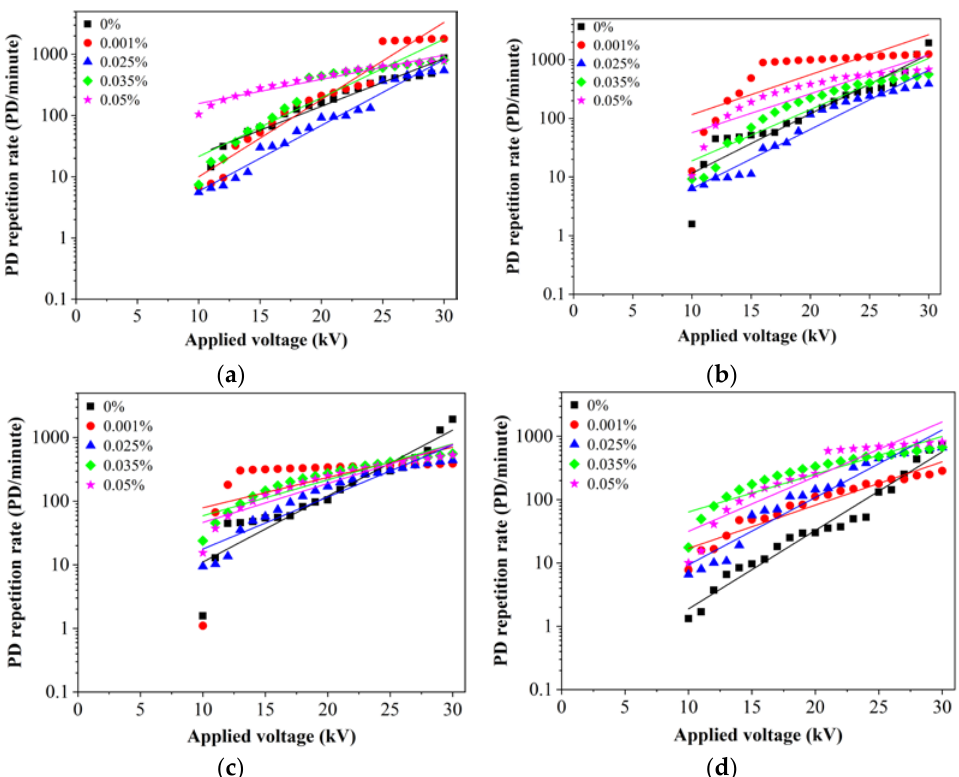
Figure 8. PD repetition rate versus applied voltage for ( a ) RBDPOA, ( b ) RBDPOB, ( c ) CO and ( d ) MO based Al 2 O 3 with SDS.